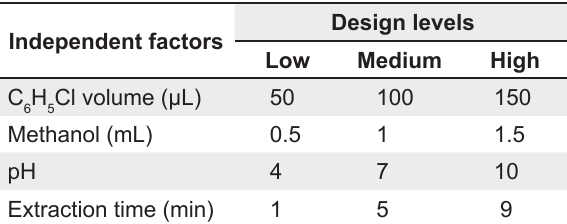
Table 1. Recovery variables and experimental design levels for response surface